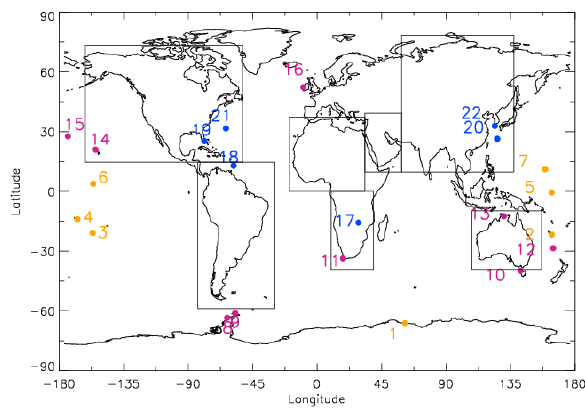
Fig. 2. Network of stations measuring surface concentration (Sect. 2.2). Stations are grouped according to the regime of mea- sured data into remote stations (orange), stations under the influence of minor dust sources of the Southern Hemisphere or remote sites in the Northern Hemisphere (violet) and finally locations directly downwind of African and Asian dust source (blue). Stations within each group are numbered from south to north. Names and locations for each selected station are given in Table S2 in the Supplement. Rectangles illustrate regions defined to compute the emissions pre- sented in Table